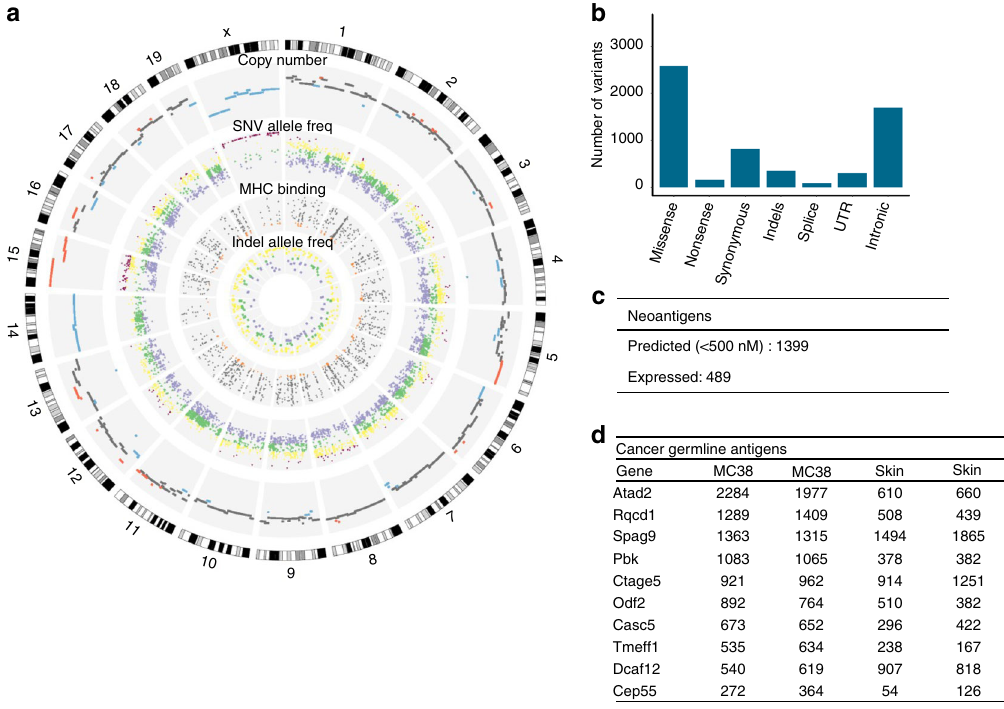
Fig. 1 Immunogenomic and transcriptomic characterization of the mouse MC38 cell line. a Circos plot showing (outer to inner): cytogenetic bands in black, gray, and white. Track 1: DNA copy number log ratio values. Dark gray: diploid; Red: ampli fi cation (log ratio > 0.25); Blue: deletion (log ratio < − 0.25). Track 2: Point mutations, plotted based on the variant allele frequency. Inner is frequency 0, outer is 100. Colors are purple (0 – 40), green (40 – 60), yellow (60 – 80), and pink (80 – 100). Track 3: Predicted MHC binding IC50 scores for the nonsynonymous mutations. Mutations with the highest binding af fi nity are colored orange (IC50 < 50). Track 4: insertions and deletions colored according to their allele frequency. b Number of mutations in MC38 classi fi ed by type. c Number of predicted and expressed neoantigens in MC38. d Known germline antigens with the highest expression in MC38. The expression values are in normalized